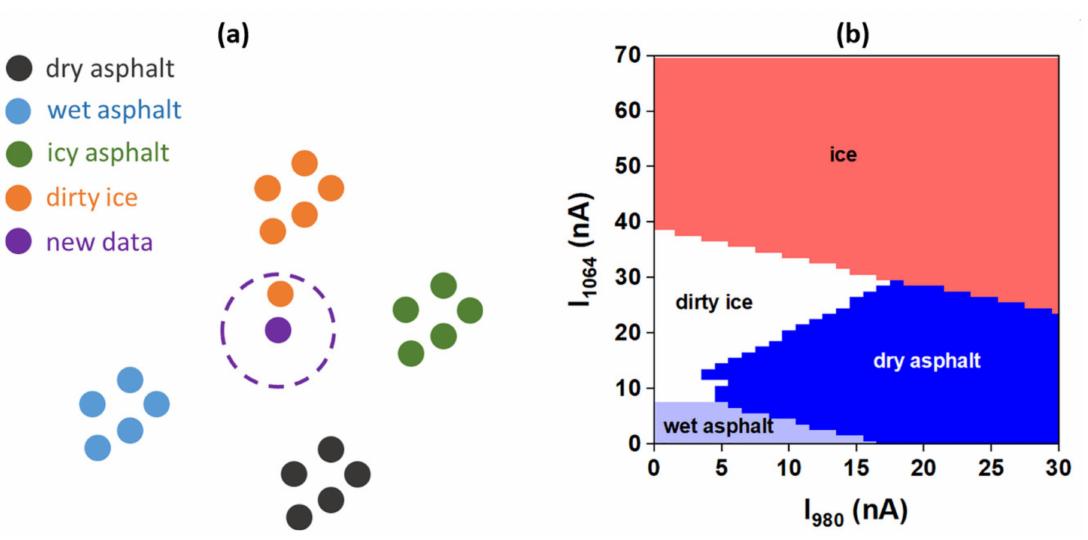
Figure 7. K-nearest neighbor (KNN) algorithm: ( a ) the working principle and ( b ) KNN algorithm applied to array